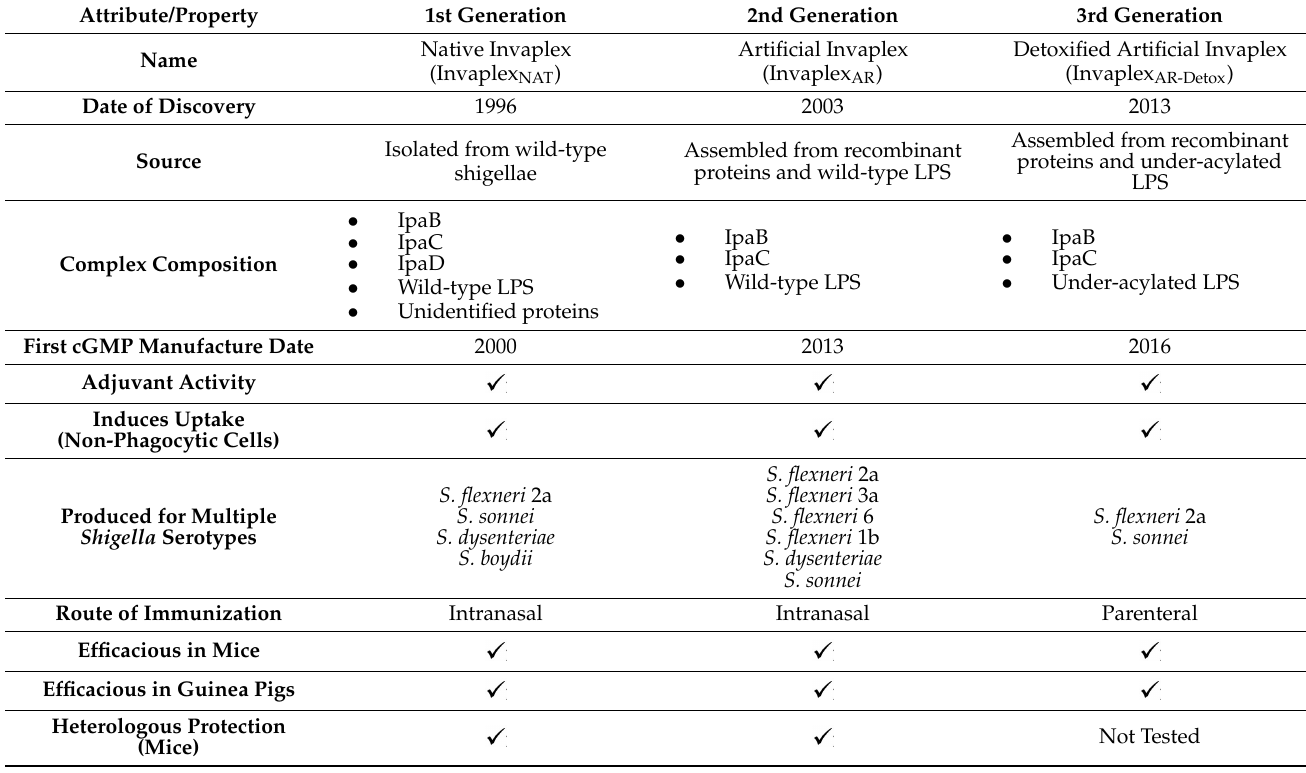
Table 1. Summary of the Invaplex product